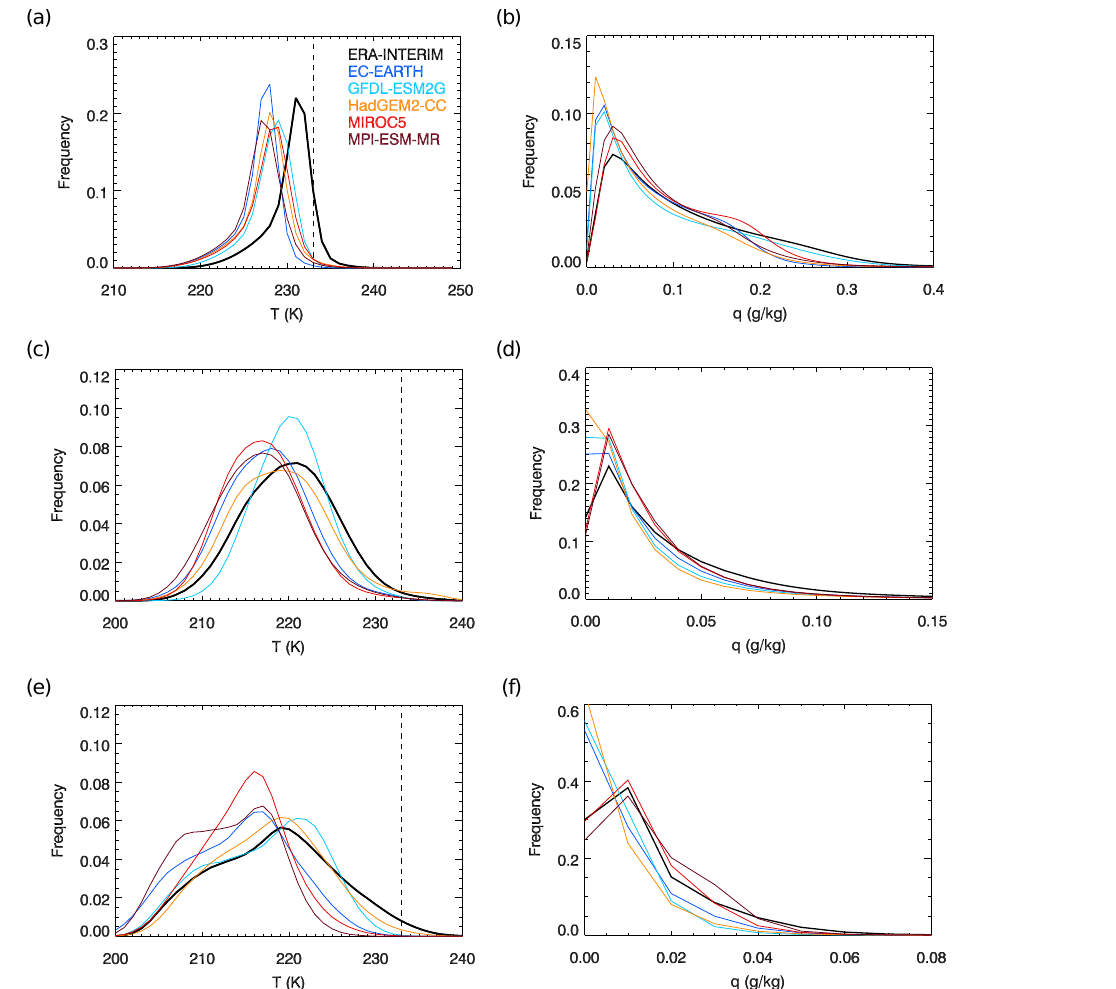
Figure 3. PDFs of temperature, T (left column), and specific humidity, q (right column), at 250hPa in the present-day climate (1979–2005) in three regions – (a, b) the tropics, (c, d) the NH mid-latitudes and (e, f) the NH polar regions – shown for ERA-Interim reanalysis (black line) and CMIP5 models EC-EARTH (dark blue), GFDL-ESM2G (light blue), HadGEM2-CC (orange), MIROC5 (red) and MPI-ESM-MR (dark red). The 233K temperature threshold is marked by the dashed line on panels (a) , (c) and (e)